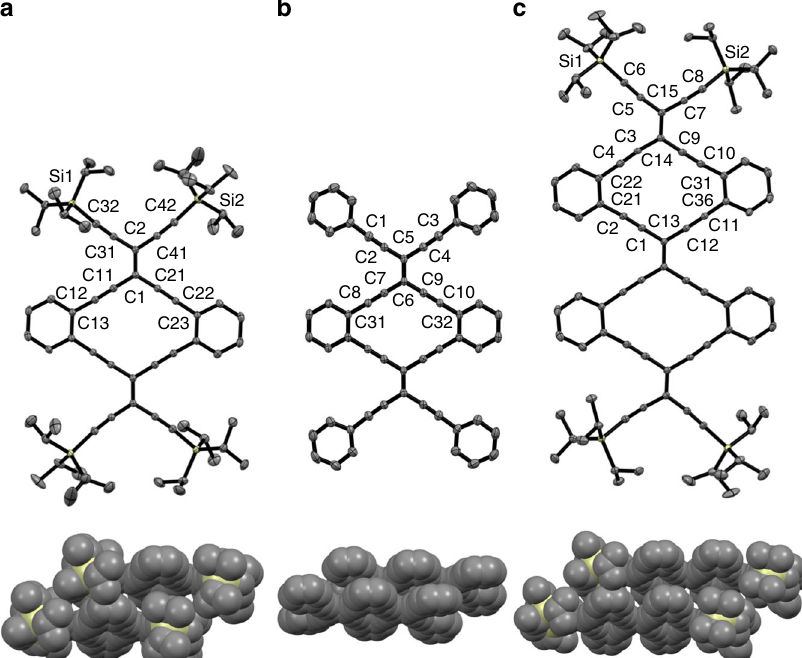
Fig. 4 Molecular structures obtained by X-ray crystallography. ORTEP structure (top) and solid-state packing (bottom) of ( a ) radiaannulene 4a , ( b ) radiaannulene 4b , and ( c ) radiaannulene dimer 5 ; selected bond lengths [Å] and angles [°] 4a : C(1) – C(2) 1.378(2), C(11) – C(12) 1.201(3), C(21) –